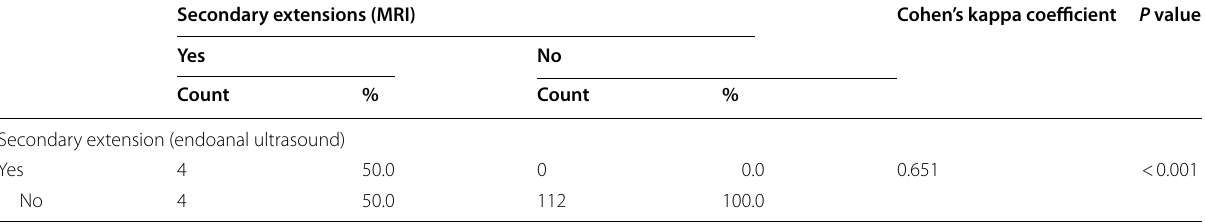
Table 4 Comparative study between endoanal ultrasound and MRI in detection of secondary extensions